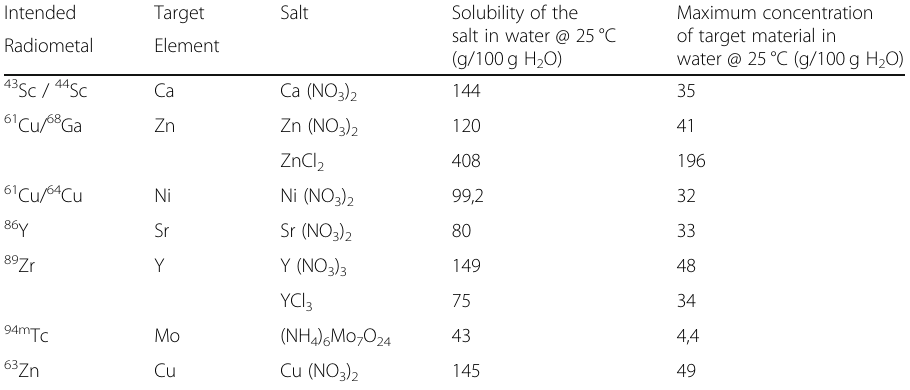
Table 3 Solubility of different substances of interest for the production of emerging radiometals, in water at 1 atm pressure and 25 °C (Handbook of chemistry and physics 2005)